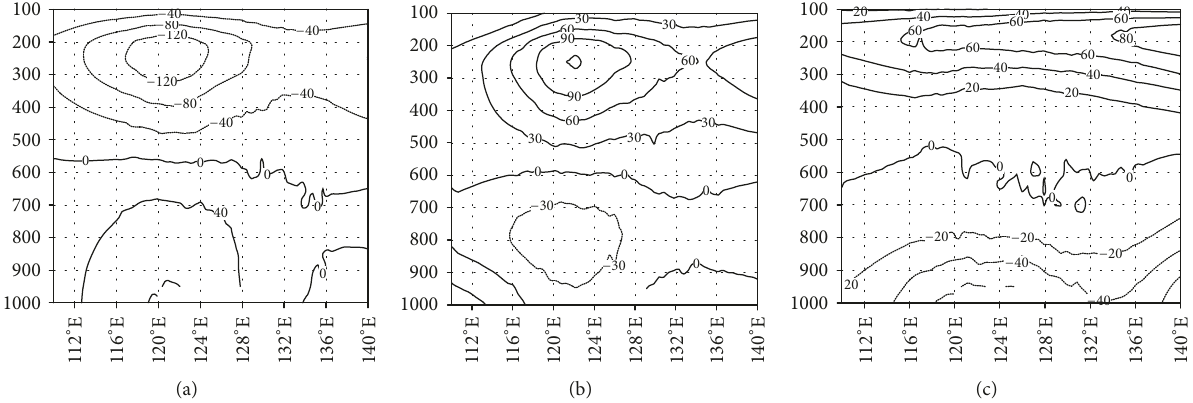
Figure 8: The initial bias of geopotential height in vertical section (unit: m 2 /s 2 ) (a) AIRS-CTRL; (b) AIRS_GRD-AIRS; (c) AIRS_SYB-AIRS.